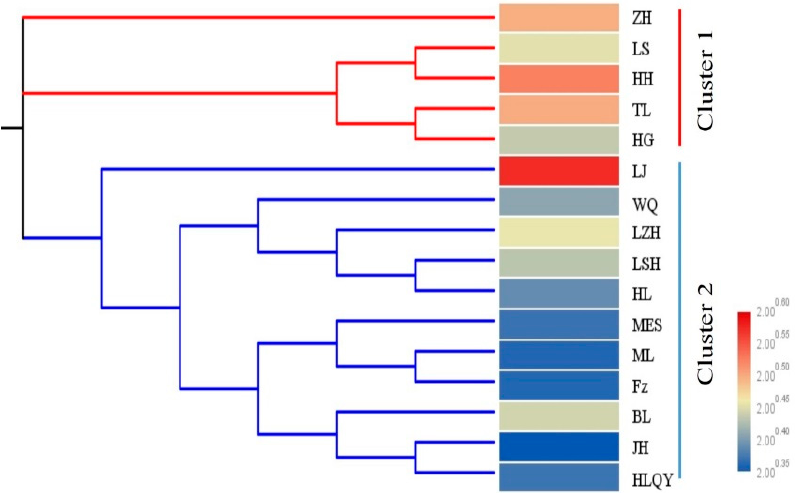
Figure 4. NJ dendrogram of 16 populations based on Nei’s (1983) genetic distance and a heatmap of expected heterozygosity (He) of 16 populations.